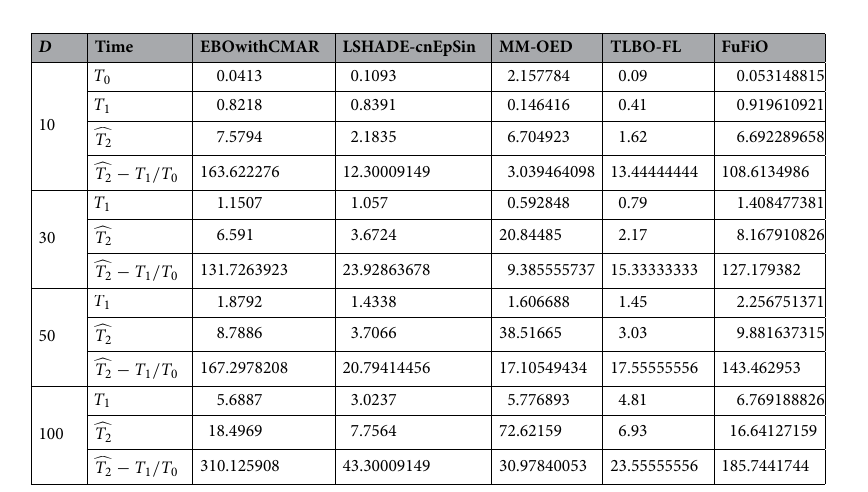
Table 17. Computational complexity of the FuFiO algorithm versus the other